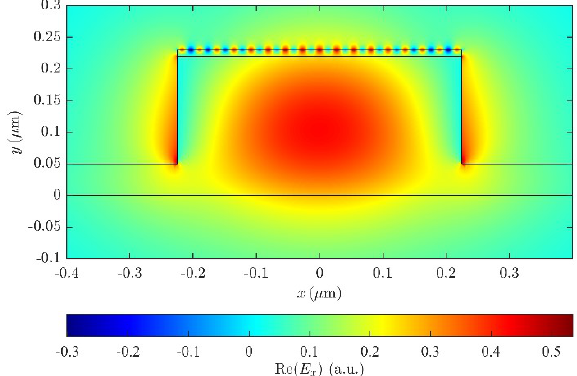
Fig. 2. Distribution of the horizontal ( E x ) component of the fundamental quasi-TE mode. The chemical potential of graphene is µ = 1.61 C